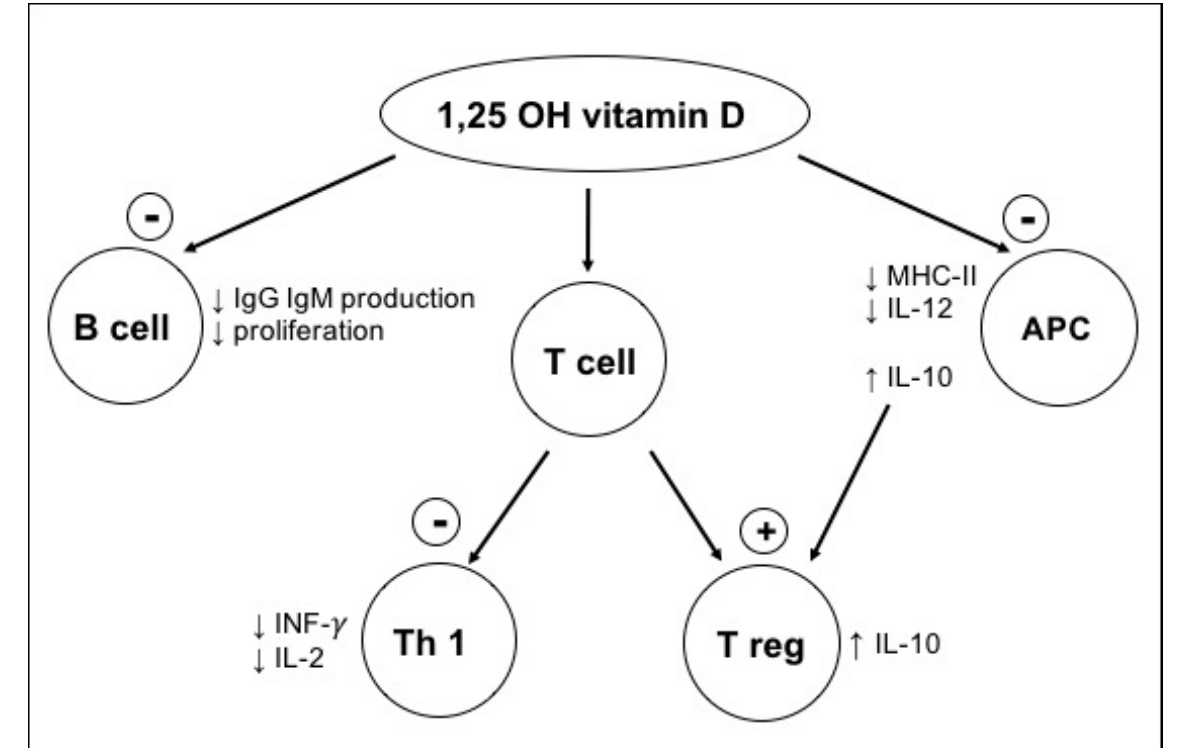
Figure 1. Immunomodulatory role of 1,25 (OH) vitamin D. Figure adapted from [18].